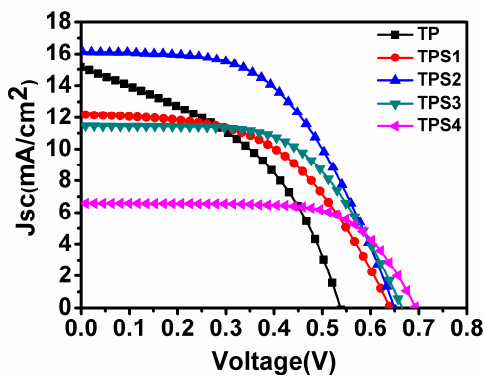
Figure 4. J–V characteristic curves of various DSCs based on TP, TPS1, TPS2, TPS3, and TPS4. Table 1. Characteristics of the SnO 2 photoanodes together with the corresponding photovoltaic parameters. FF, PCE, power conversion efficiency.